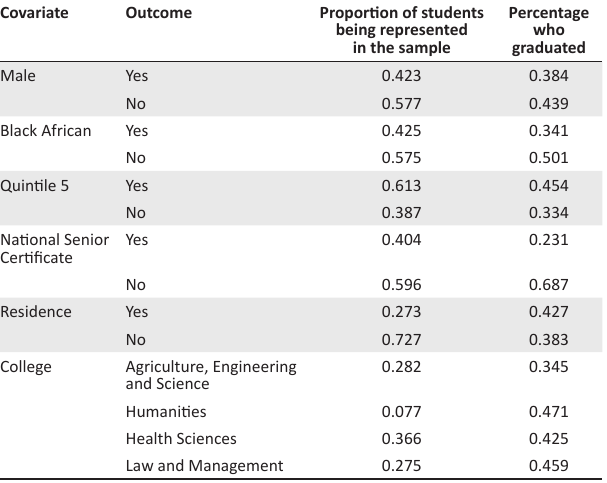
TABLE 5: A demographic breakdown of graduation rates at this university. Covariate Outcome